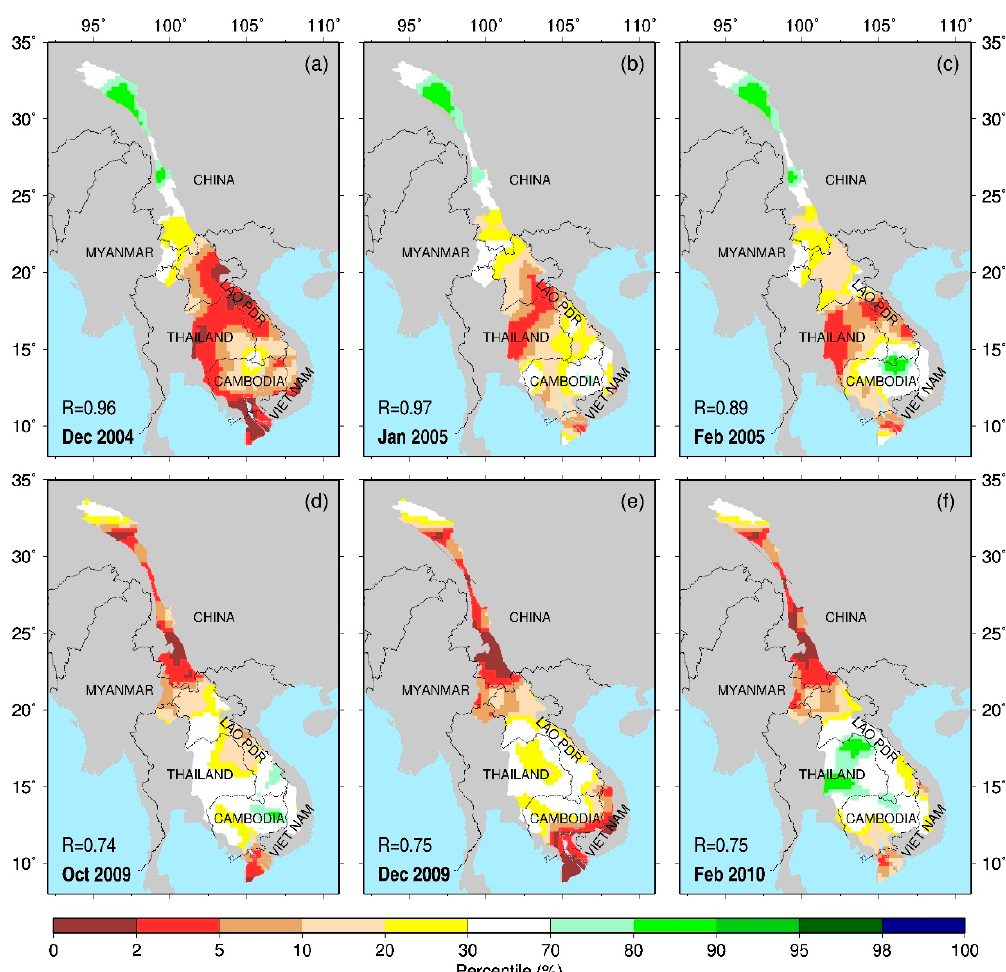
Figure 10. Monthly drought monitoring estimated from the combination of the VIC model and the bias-corrected satellite real-time meteorological data in three typical months during 2004/05 drought ( a – c ) and 2009/10 drought ( d – f ), respectively.